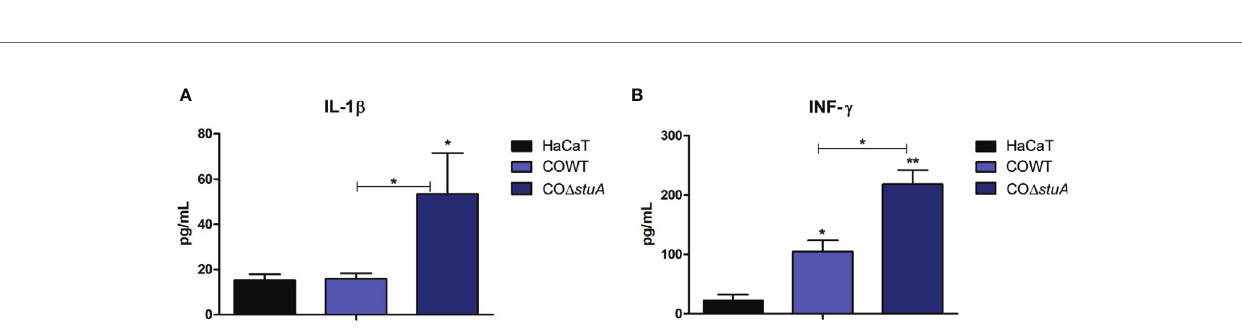
FIGURE 5 | stuA deletion induces a proin fl ammatory pro fi le in human keratinocytes. Levels of pro-in fl ammatory cytokines produced by HaCaT cells after coculture with conidia from wild-type and D stuA strains of T. rubrum for 24 h. Comparison of (A) interleukin (IL)-1 b and (B) interferon (INF)- g secretion induced by each strain. Statistical signi fi cance was determined using ANOVA followed by Tukey ’ s post-hoc test (* P < 0.05; ** P < 0.01).